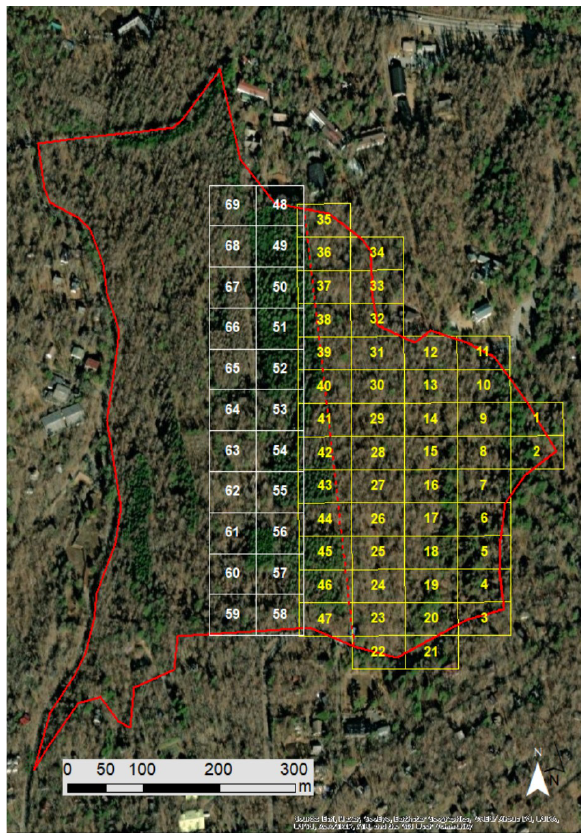
Figure 4 . Flight area is grided and numbered. Phantom 4 RTK and M2EA fly at the altitude of 80 m from the ground, from No.1 to No.47, and from No.48 to No.59 hovering at the centre of each grid for 3 seconds.